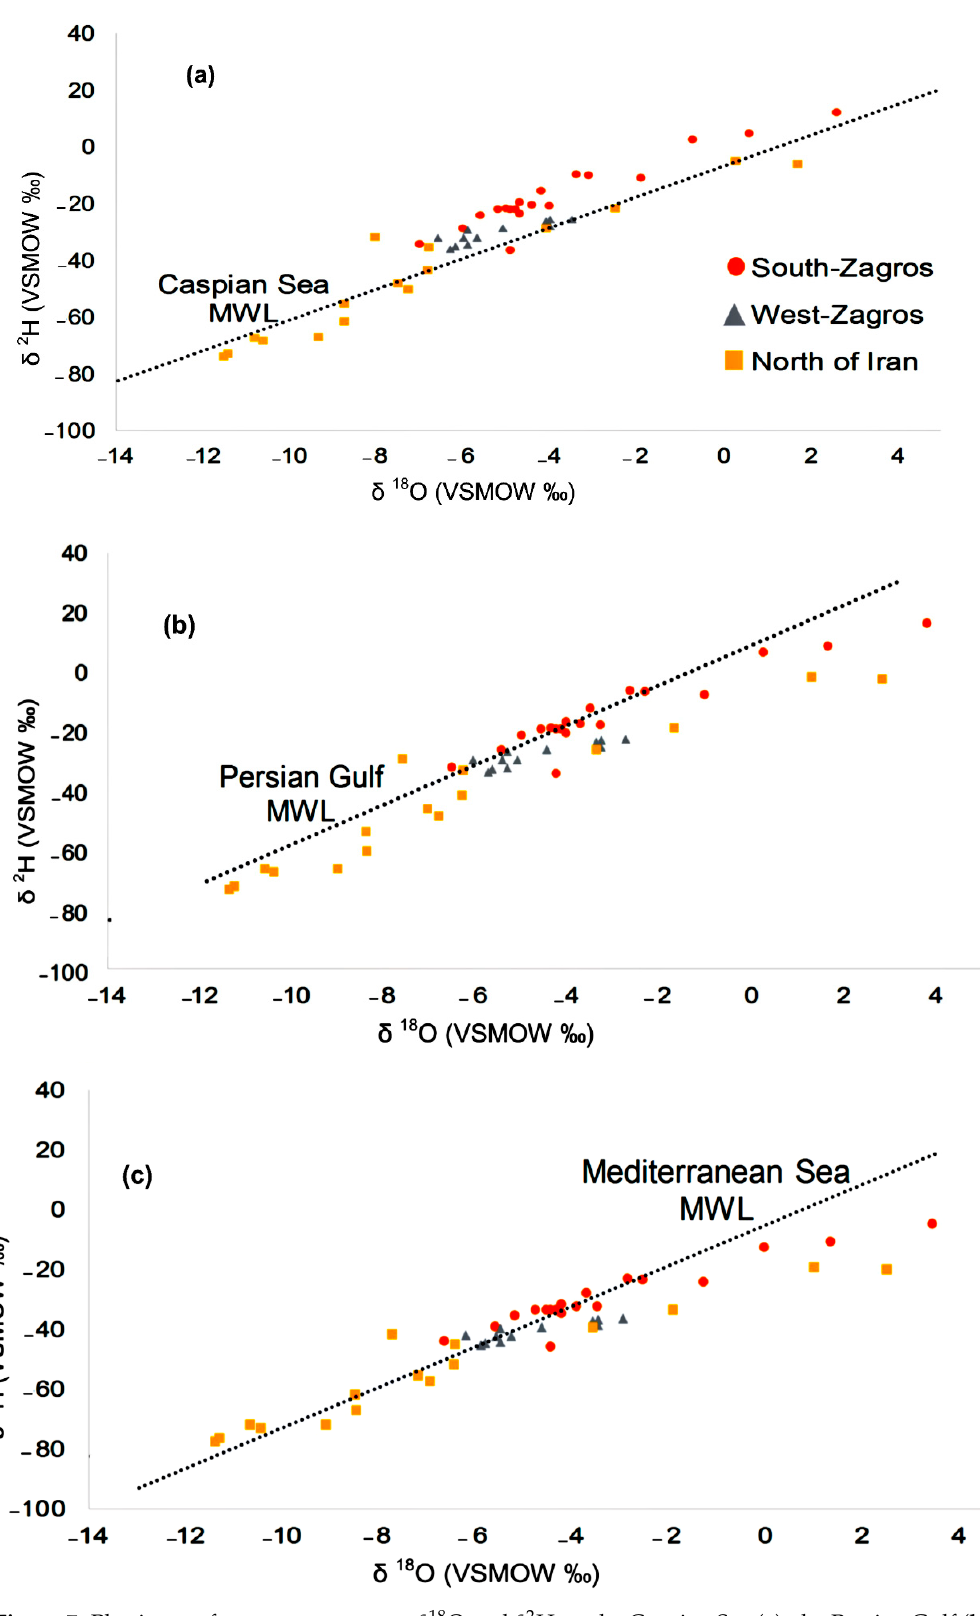
Figure 7. Plotting surface water resources δ 18 O and δ 2 H on the Caspian Sea ( a ), the Persian Gulf ( b ), and the Mediterranean Sea ( c ) MWLs. (The Mediterranean Sea, the Persian Gulf, and the Caspian Sea MWLs are taken from Figure 6.).